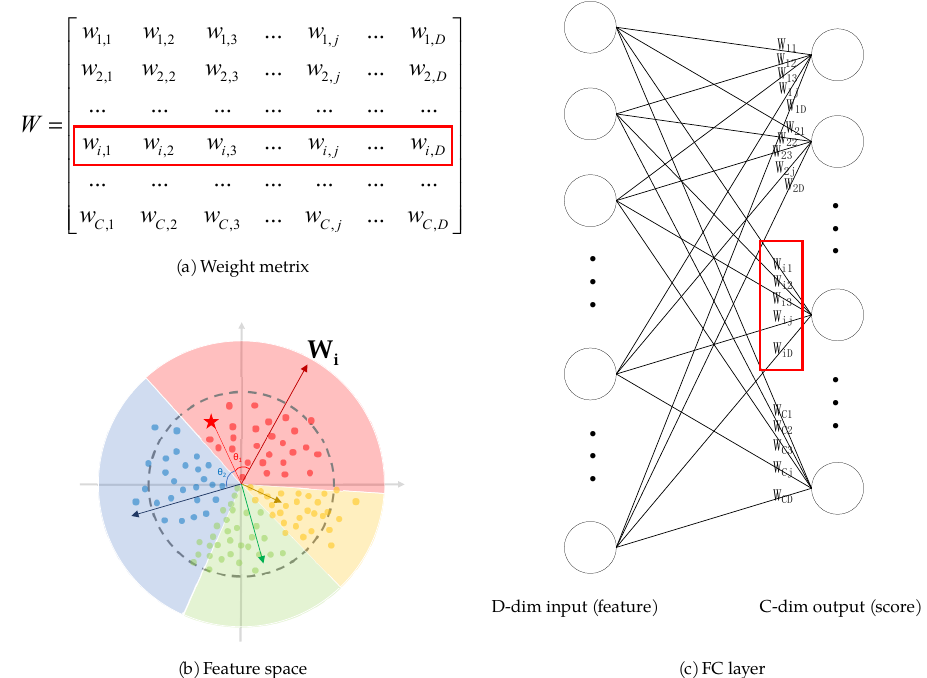
Figure 8. The relationship among ( a ) the weight matrix, ( b ) the feature space and ( c ) the FC layer.